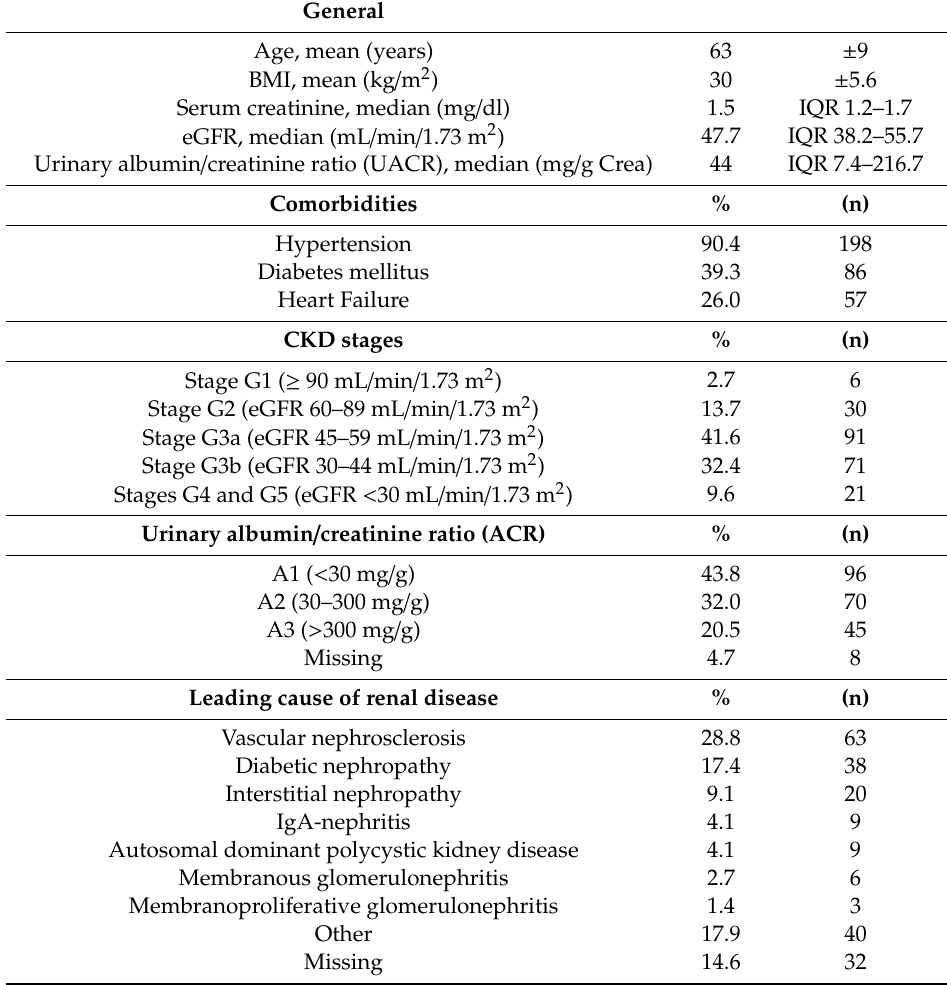
Table 1. Baseline characteristics, comorbidities, stages of chronic kidney disease (CKD), and causes of renal disease of the overall